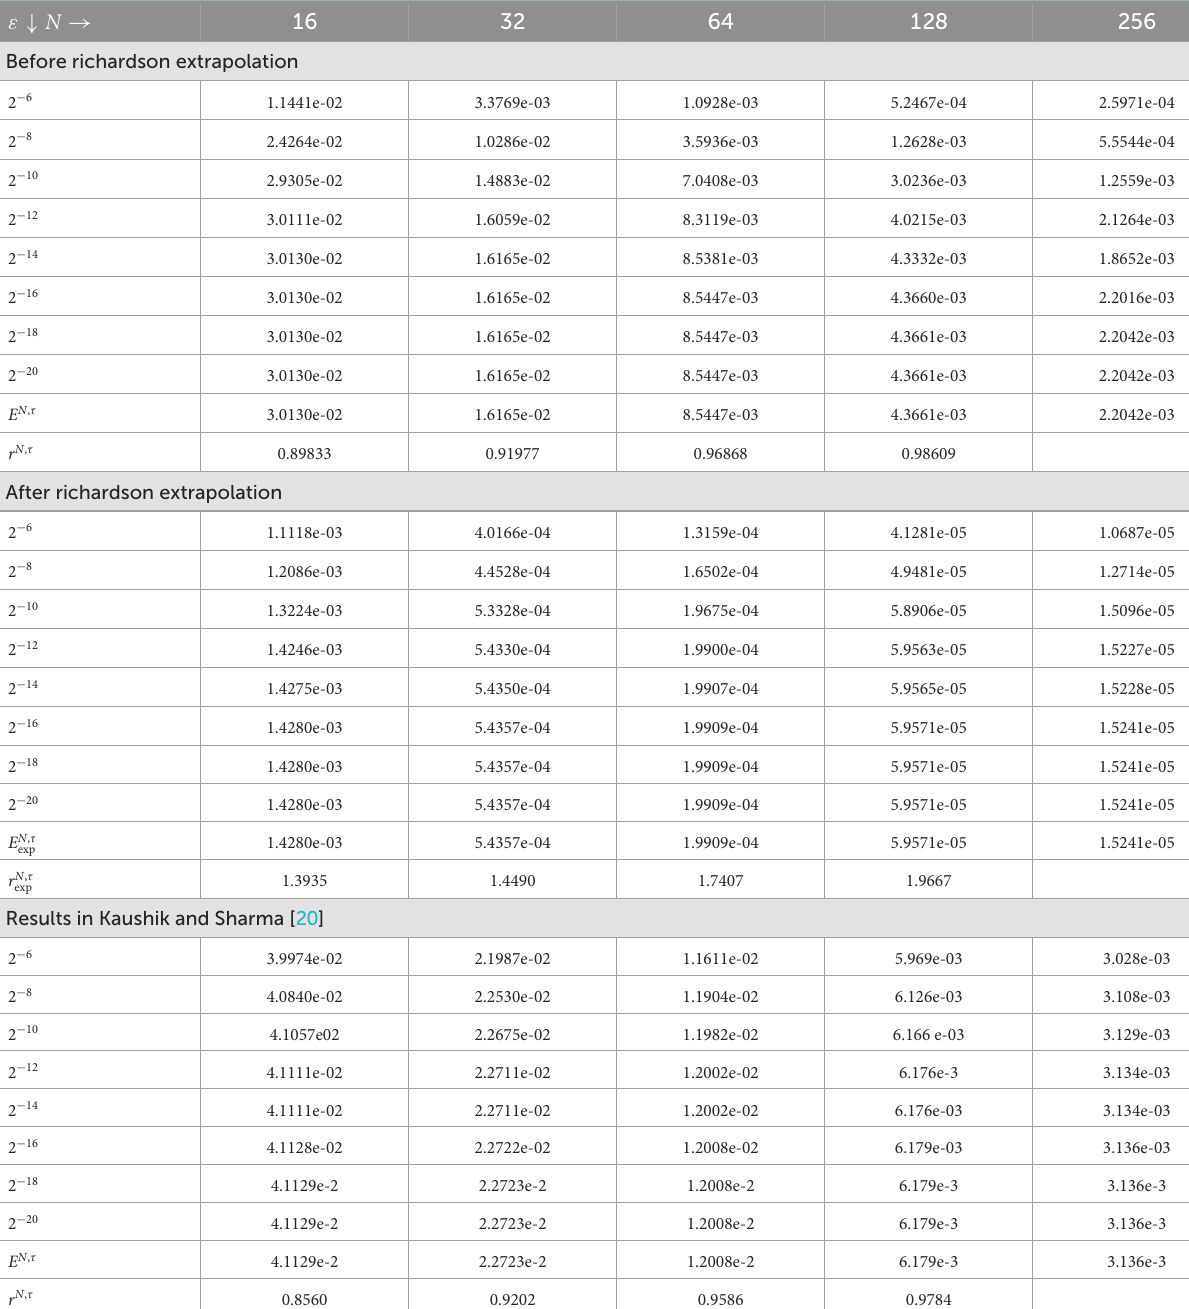
TABLE 3 Comparison of E N , τ ε , E N , τ , r N , τ , ( E N , τ ε ) extp , E N , τ extp , and r N , τ extp for Example 5.3 with results in Kaushik and Sharma [20] for τ =